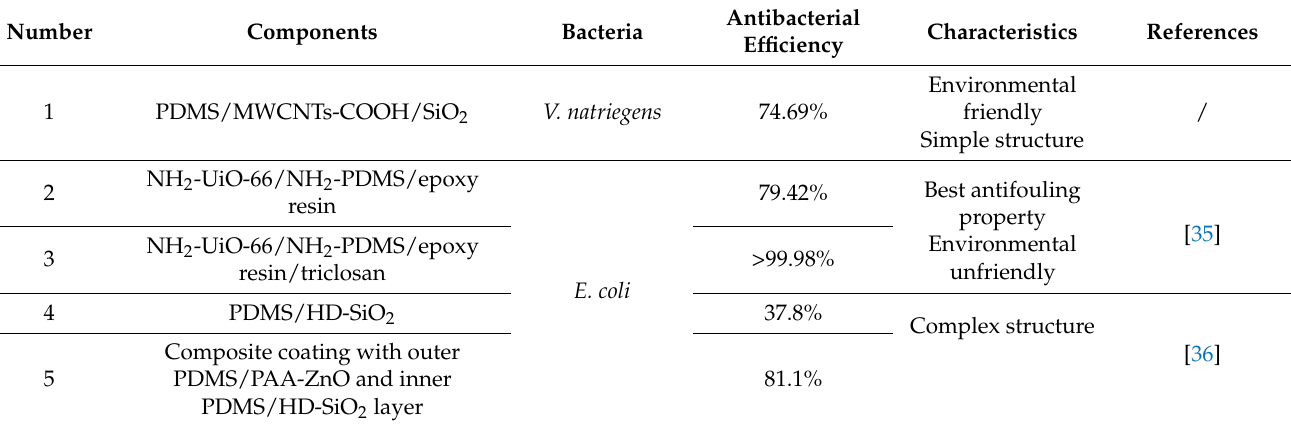
Table 5. Antifouling performance of different antifouling